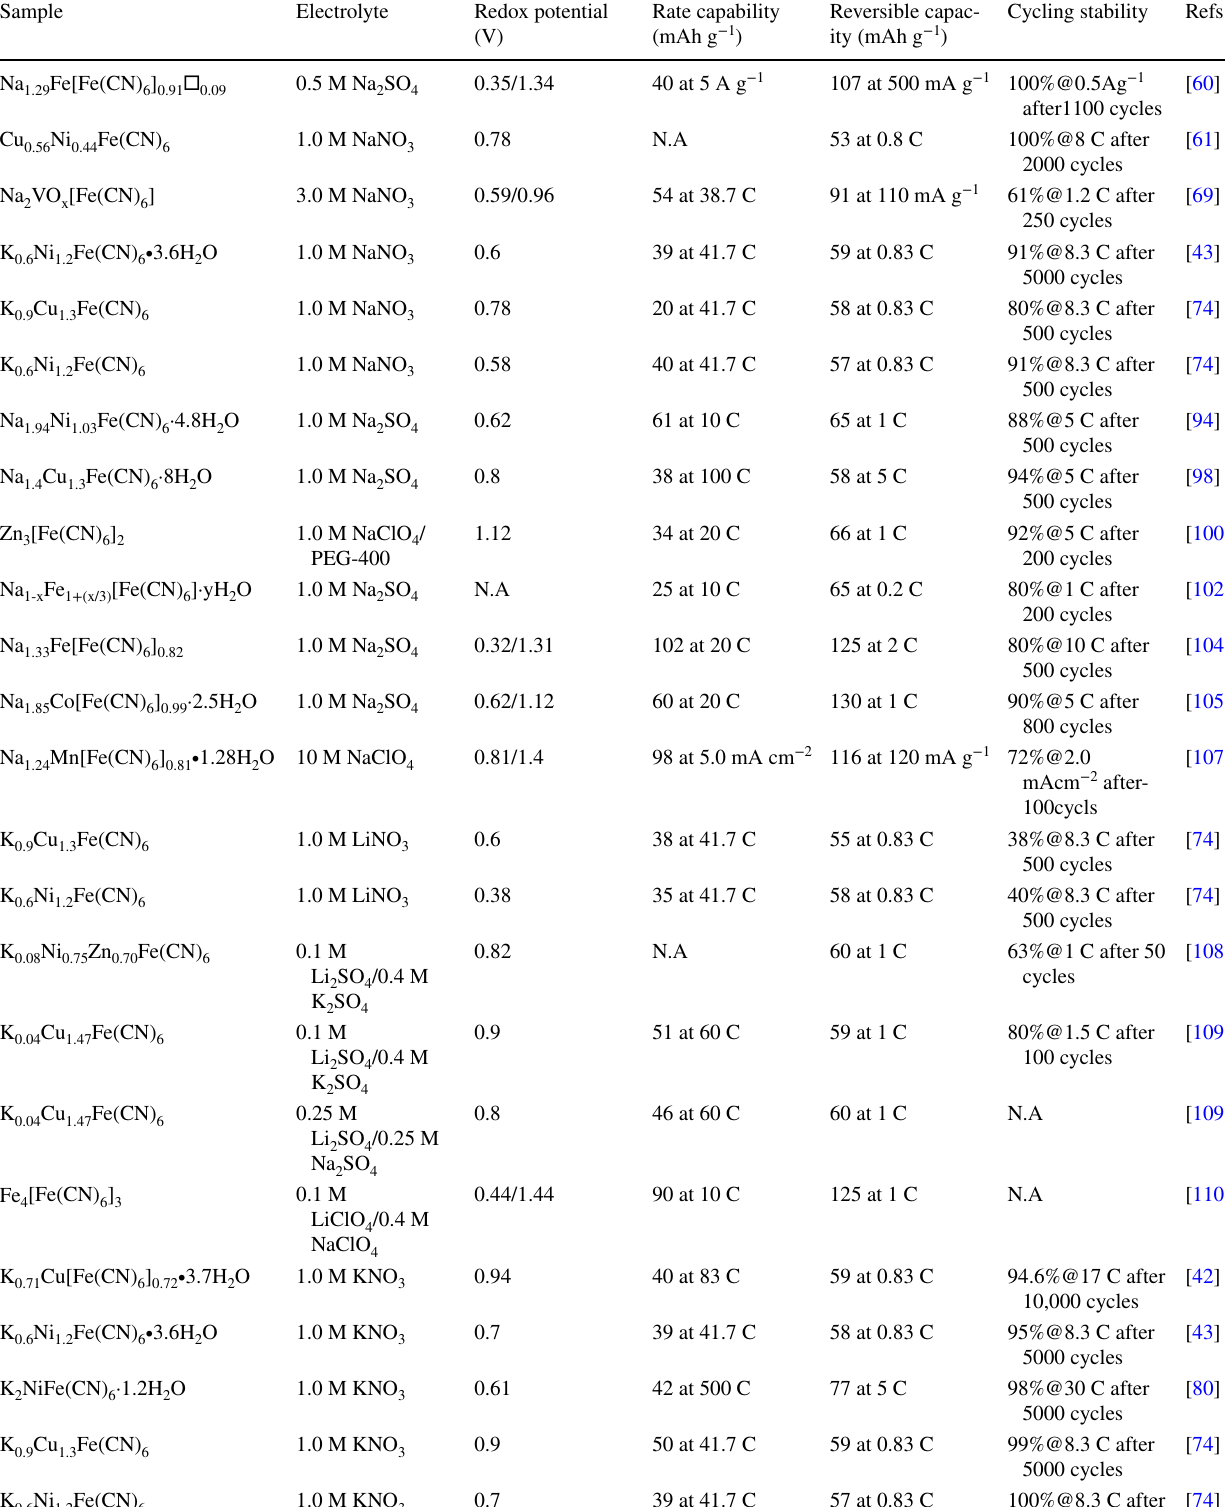
Table 1 Electrochemical performance of representative PBAs in various aqueous batteries Sample Electrolyte Redox potential